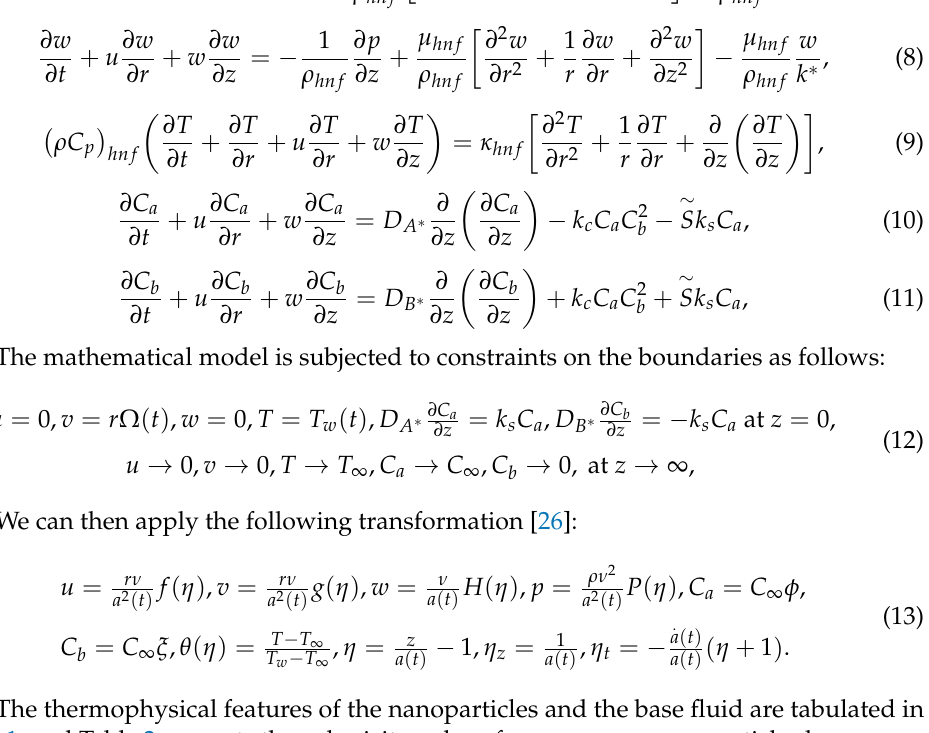
Table 1. Thermophysical characteristics of C 2 H 6 O 2 , Al 2 O 3 , and CuO [2,36]. Properties